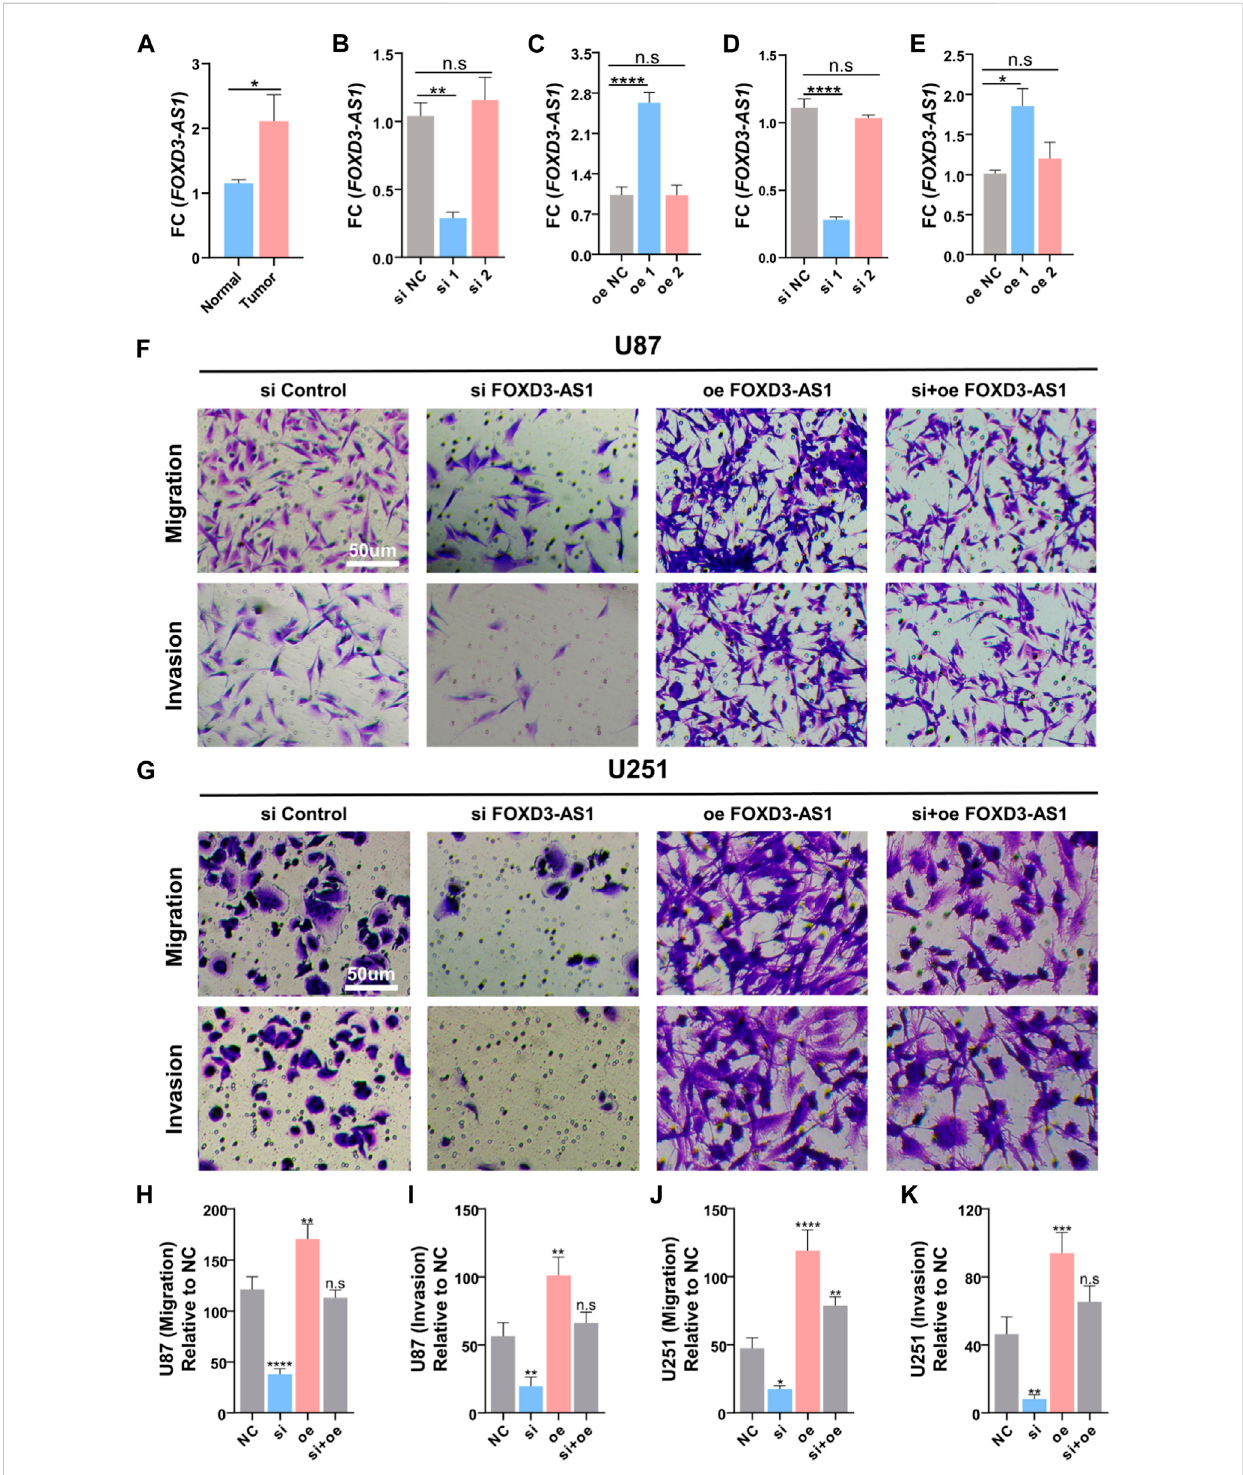
FIGURE 15 FOXD3-AS1 promotes glioma cell migratory and invasive capacity in vitro . (A) Results of RT-PCR assay on tumor tissues and paraneoplastic tissues, FOXD3-AS1 was elevated in tumor tissues. (B – E) Detection of transfection ef fi ciency of si-FOXD3-AS1 and FOXD3-AS1-overexpression in U-87 cell line and U-251 cell line using RT-PCR, and standardization of the results (F, G) Transwell assay images of migration and invasion in the negative control, FOXD3-AS1 knockout groups, FOXD3-AS1 overexpression and FOXD3-AS1 rescue groups. (H – K) Quantitative analysis of migrating and invading glioma cells. n.s P (cid:1) 0.05, ** p ≤ 0.01, *** p ≤ 0.001, **** p ≤